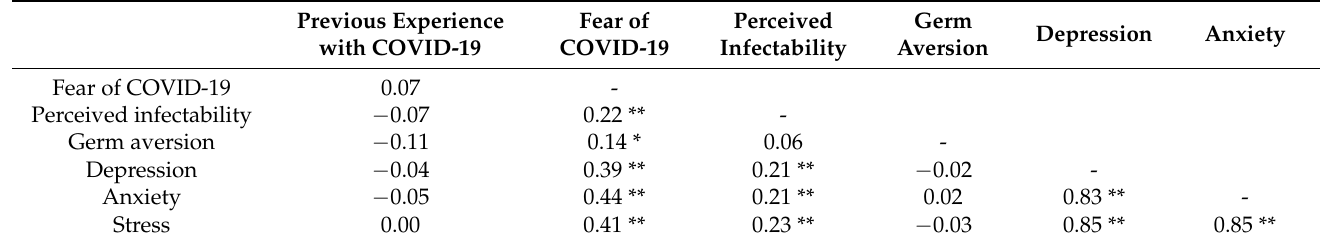
Table 3. Correlation coefficient matrix (Pearson’s r ).